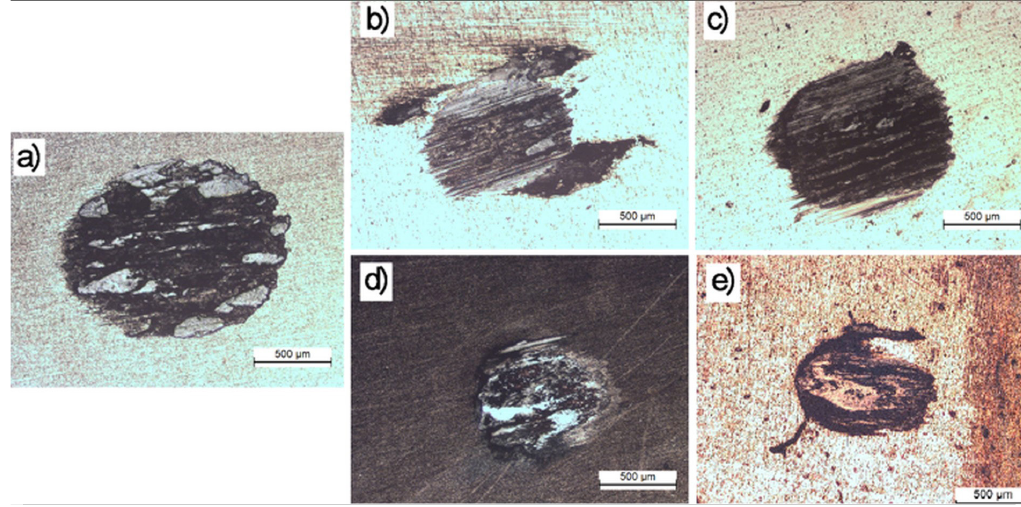
Figure 5. Trail form in the wear test for each sample. a) Base, b) PN400, c) PN450, d) CCPD400, and e) CCPD450.